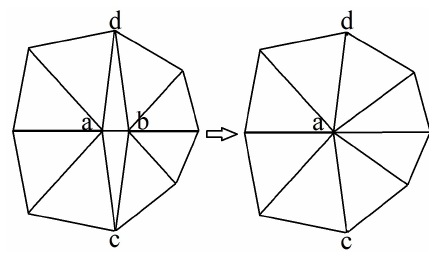
Figure 3. Short edge collapse: the operation of short edge collapse combines v a and v b to v a and removes faces f abc and f abd